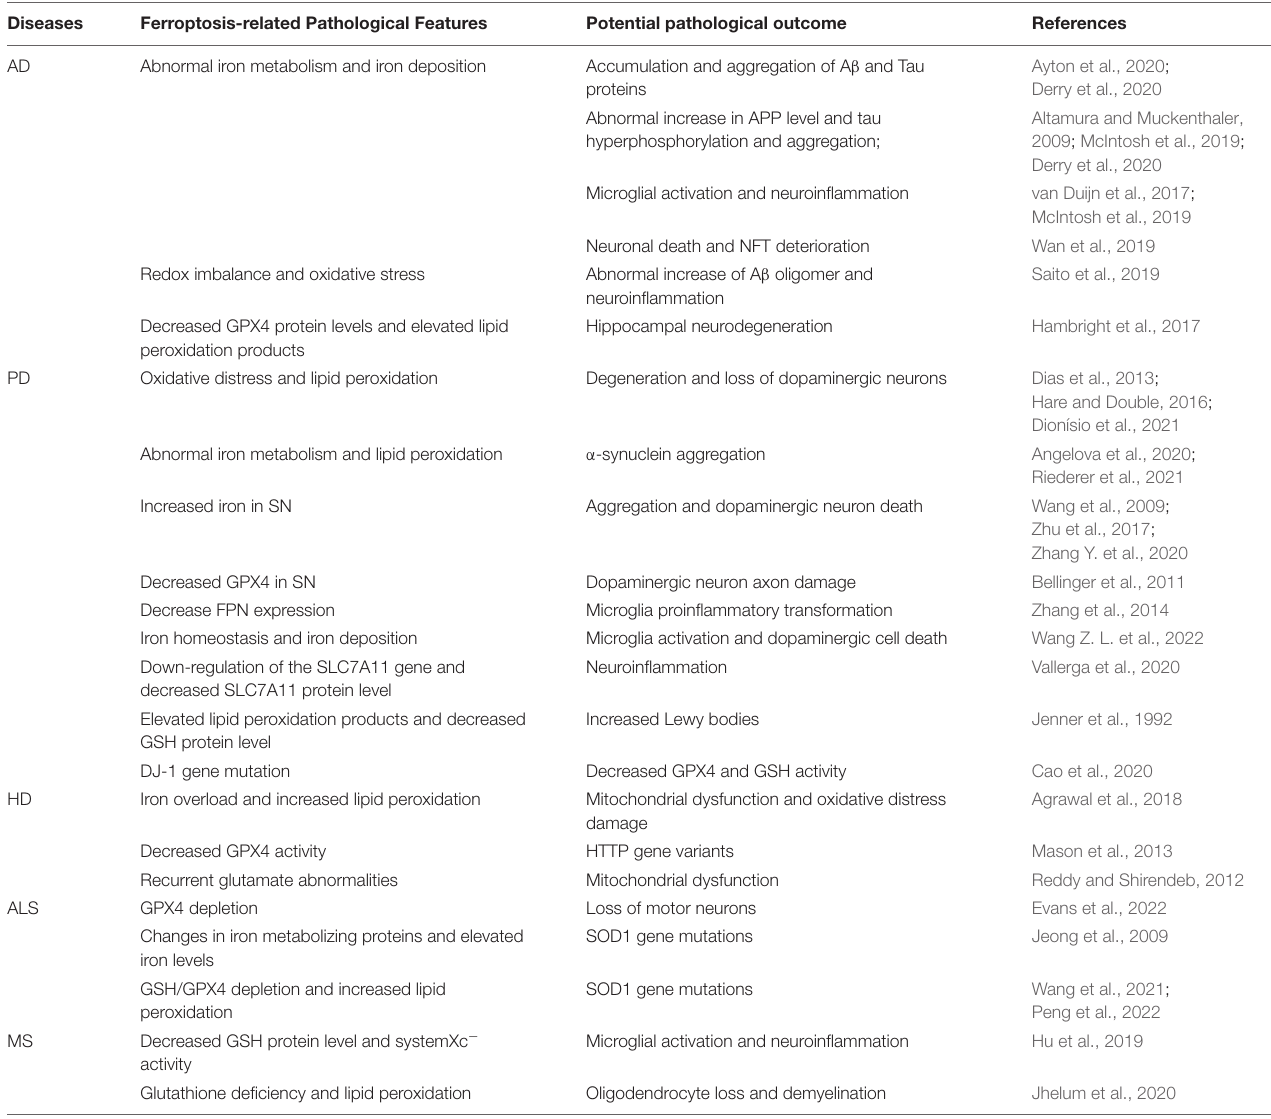
TABLE 2 | Pathological changes of NDDs associated with pathological features of